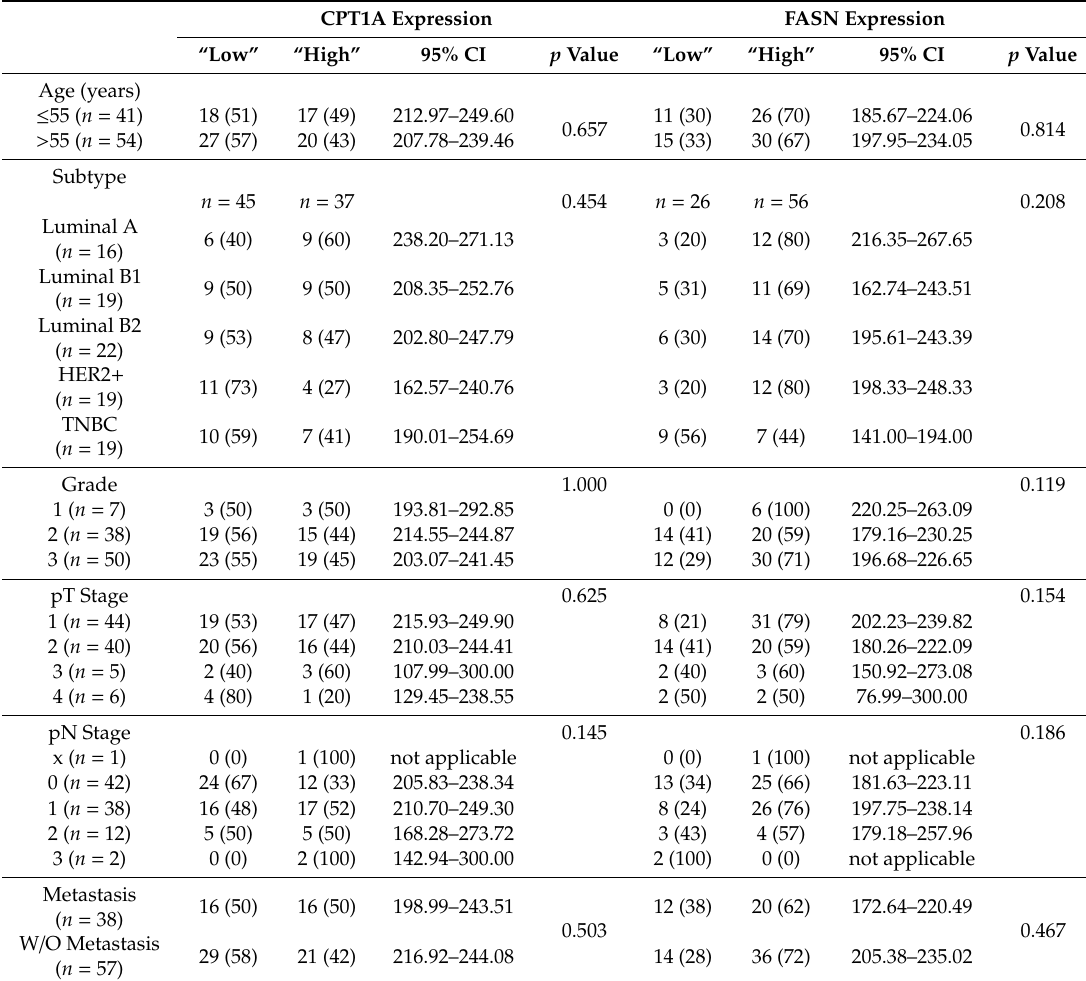
Table 3. Correlation of clinicopathological parameters of breast cancer patients with CPT1A and FASN expression (determined by IHC). p <